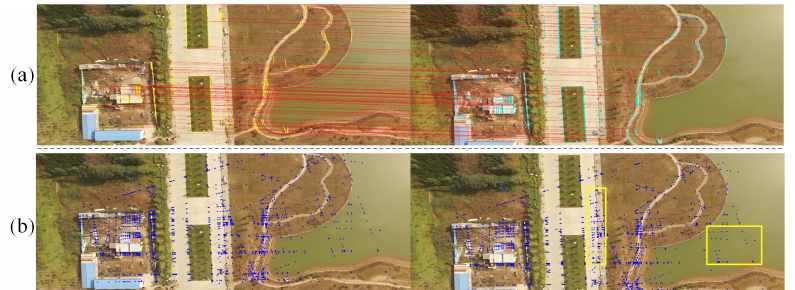
Figure 6. Illustration of the distribution of the LSVI matching points. ( a ) Matched line segments. The matched line segments are connected by red lines, and the matched line segments are represented by yellow and cyan short lines, respectively. ( b ) LSVI matching points. The LSVI matching points are represented by blue dots.